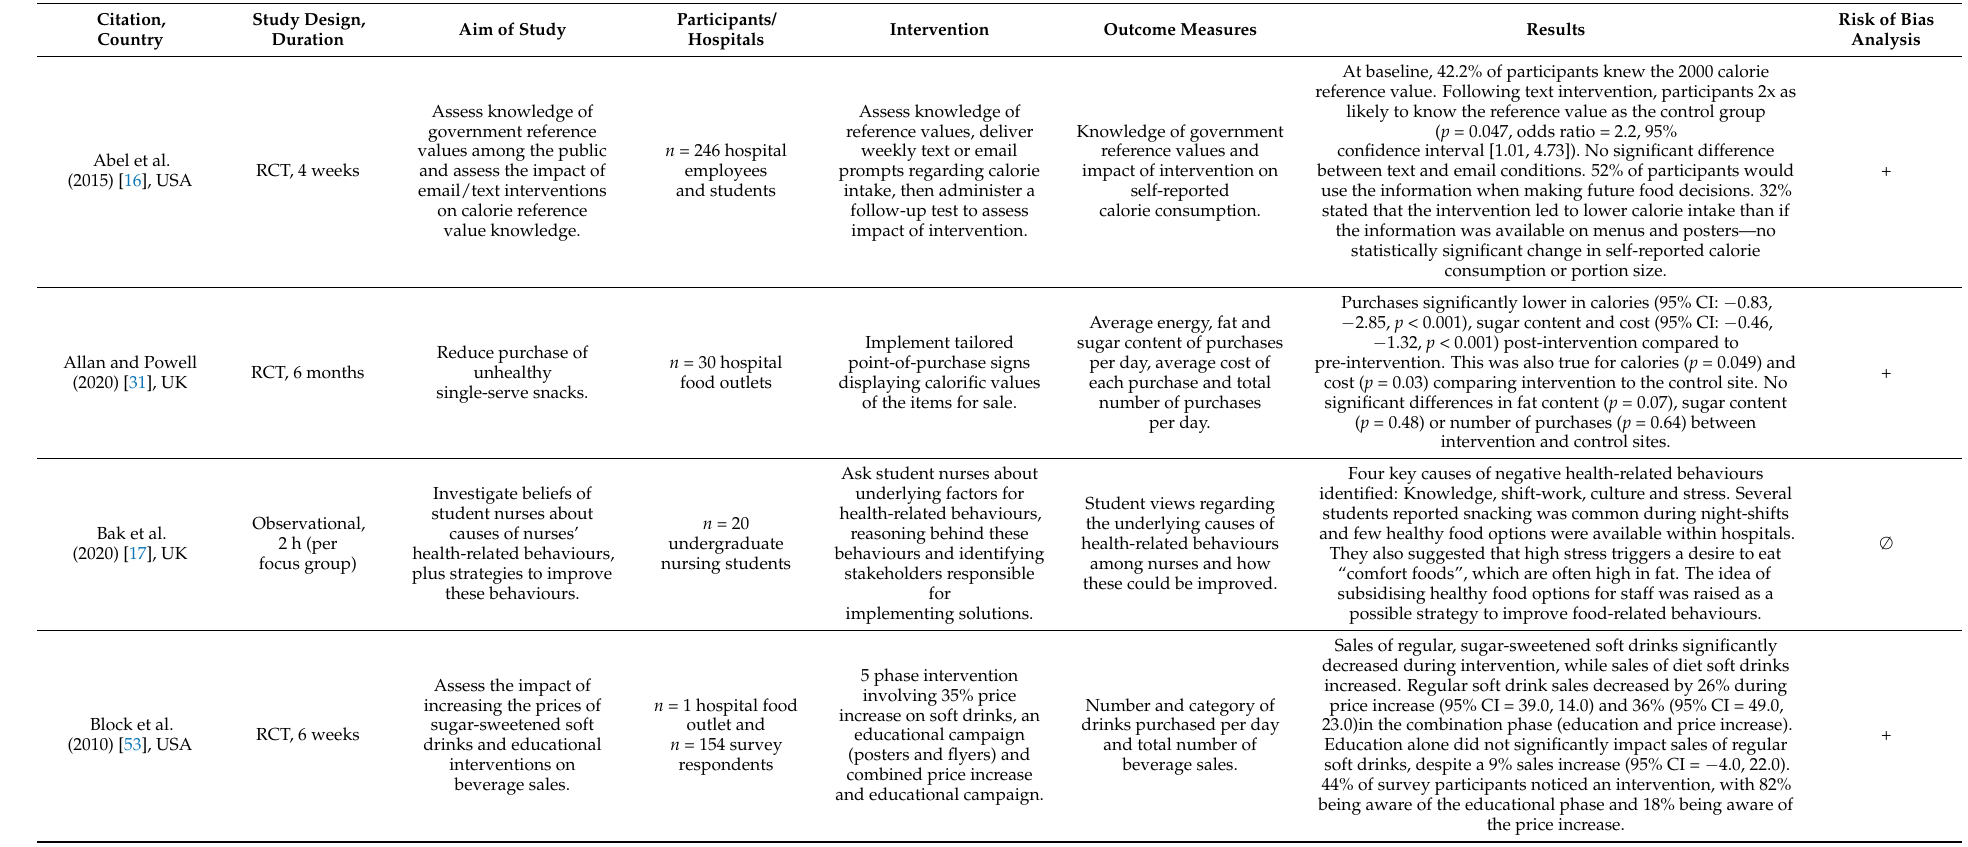
Table A1. Full data extraction for n = 40 studies, including quality assessment and risk of bias analysis, carried out using the Quality Criteria Checklist for Primary Research